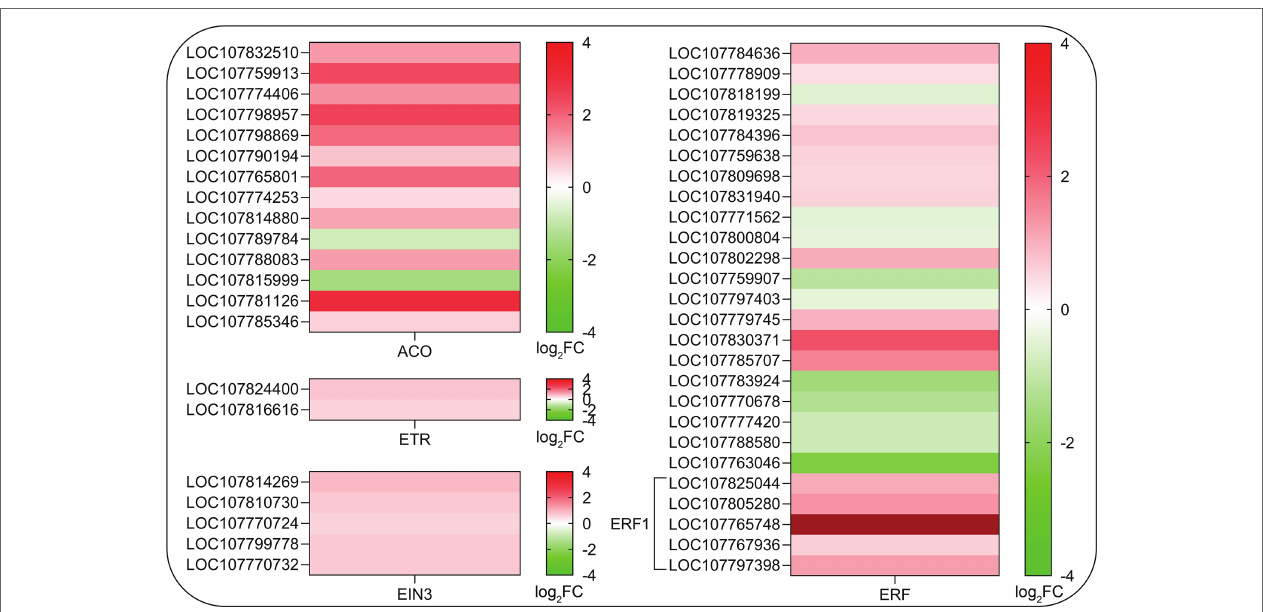
FIGURE 8 | Comparison of DEGs related to ethylene biosynthesis and signaling transduction pathway on SHAM treatment. ACO, 1-aminocyclopropane-1- carboxylate oxidase; ETR, ethylene receptor; EIN3, ethylene insensitive 3; and ERF, ethylene response factor. log 2 FC, log 2 FoldChange.